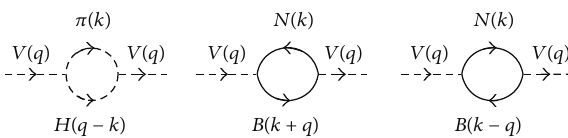
Figure 17: One-loop Feynman diagrams for 𝜌 or 𝜔 self-energy involving mesons (first figure) and baryons (second and third figures). 𝑉 stands for the 𝜌 or 𝜔 in the external line. In the internal lines of meson loops, 𝐻 = 𝜋 , 𝜔 , 𝑎 1 , and ℎ 1 for 𝑉 = 𝜌 whereas 𝐻 = 𝜌 for 𝑉 = 𝜔 . For the baryonic loops, 𝑁 and 𝐵 indicate, respectively, nucleon and baryonic internal